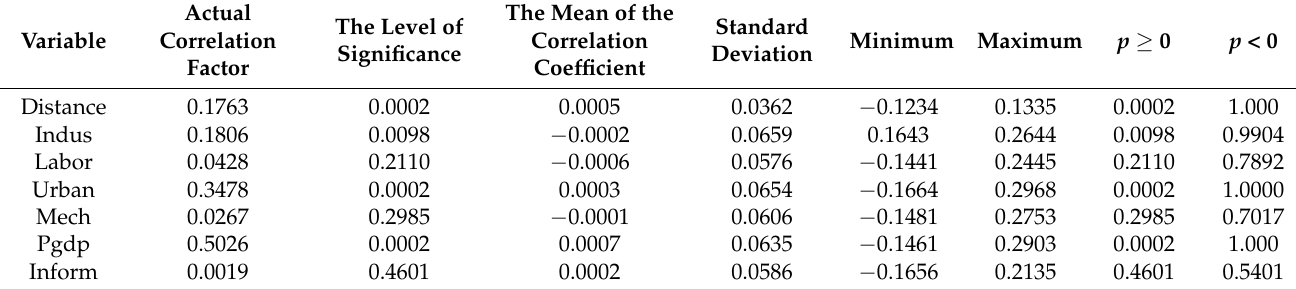
Table 9. QAP correlation analysis of the spatial correlation network and its driving factors.